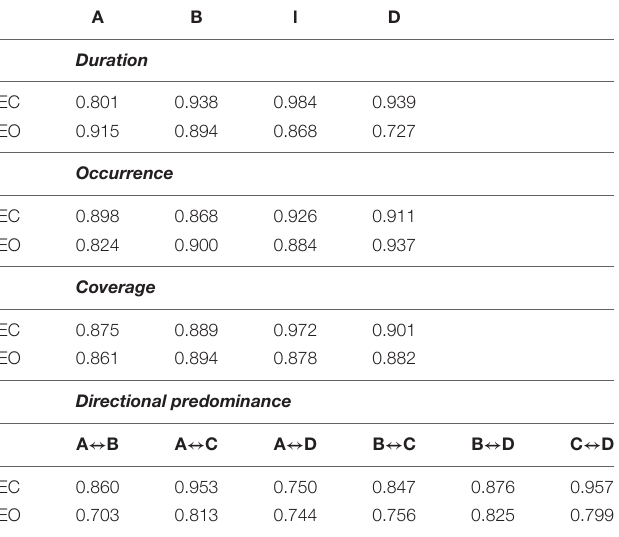
and optimized fingerprint